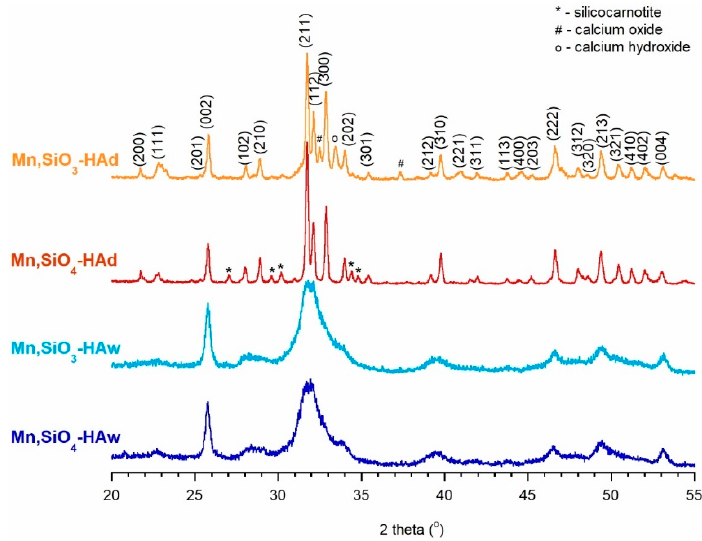
Figure 1. PXRD patterns of the analyzed samples.